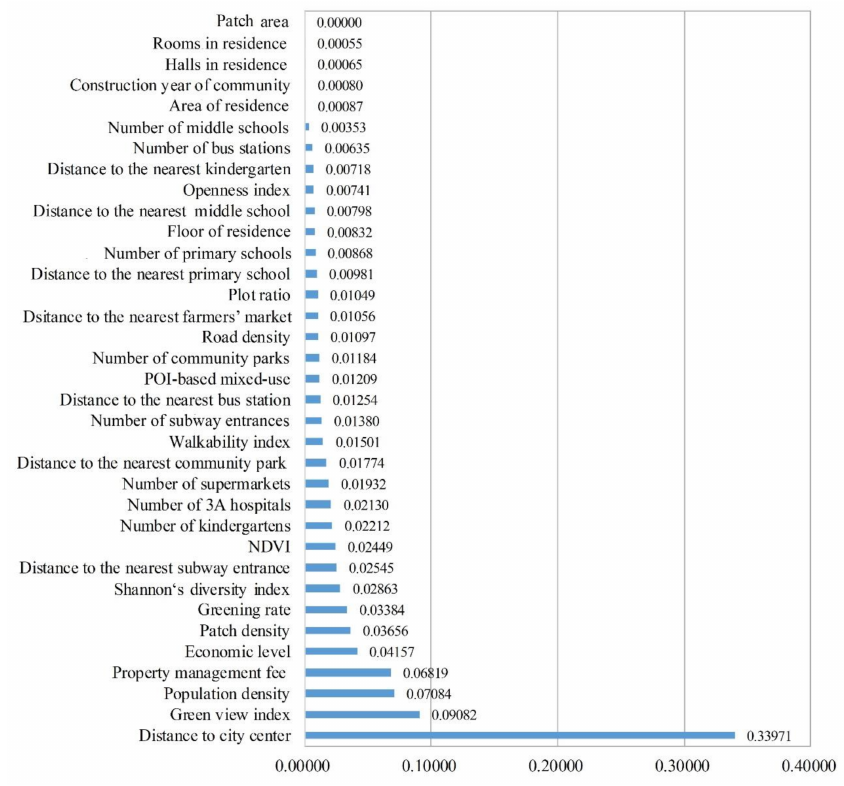
Figure 5. A list of the relative importance of influential factors on housing